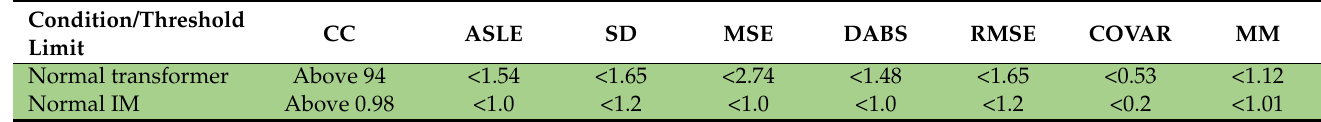
Table 11. The proposed limits to determine the good condition of transformer and induction motors using FRA and statistical